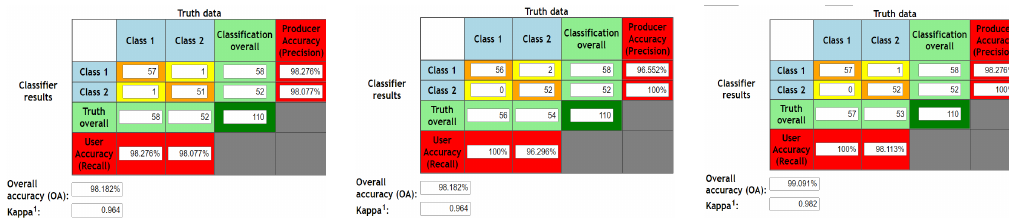
Figure 11. Confusion matrix for 10 fold cross validation of 2D images for SVM, LSTM and VAE-CNN respectively.